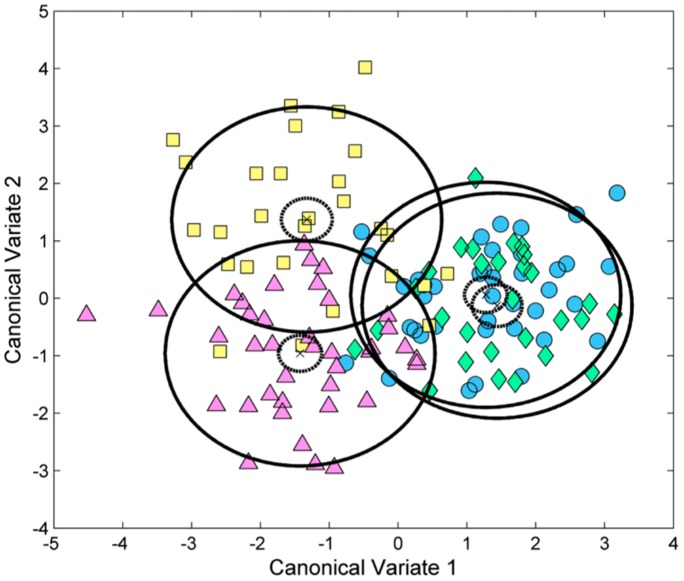
Canonical Variate Analysis for the combined data sets.Squares = asphyxia cases; Circles = matched asphyxia controls; Triangles = HIE cases; Diamonds = matched HIE controls. Solid circles = 95% confidence intervals for each group population; Dashed circles = 95% confidence intervals for the mean of each group.